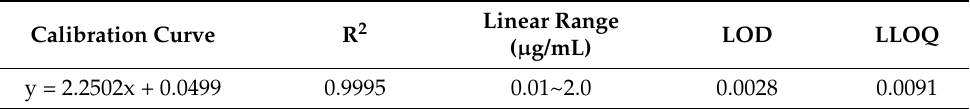
Table 1. Summary of the calibration curve, linear range, LOD and LOQ for the quantification for SFN in rat plasma by the HPLC method.